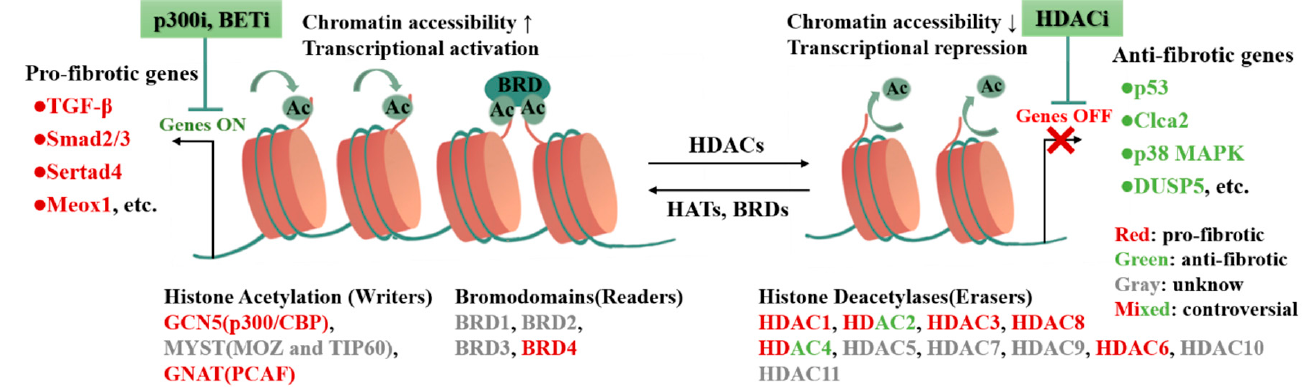
Figure 3. Histone acetylation modifications regulate fibrosis-related genes involved in CFs activation and cardiac fibrosis. The processes of histone acetylation and deacetylation are dynamically reversible, and histone acetylation modification states determine the chromatin accessibility as well as further transcriptional activity of fibrotic genes. HATs as writers and BRD4 as readers enhance chromatin accessibility and activate transcription, promoting pro-fibrotic gene expression. Conversely, HDACs mediate deacetylation as erasers, which reduce chromatin accessibility, repress transcription and participate in the epigenetic silencing of anti-fibrotic genes. As shown in the figure, different colors suggest different genes, and epigenetic-modifying enzymes play different roles in cardiac fibrosis. The application of p300i, BETi, and HDACi can target to alleviate histone acety-